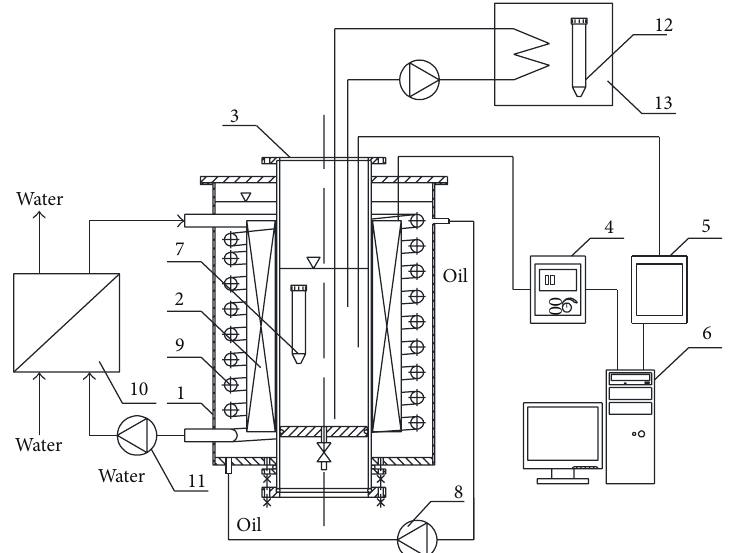
Figure1:Experimentalset-up: 1 —housing;2—generatorofRMF;3—cylindricaltubewithbottom;4—a.c.transistorizedinverter;5—thermal control system; 6—personal computer; 7—test tube; 8—circulating pump for oil; 9—cooling coil; 10—heat exchanger; 11—circulating pump for coolant; 12—control tube; 13—water